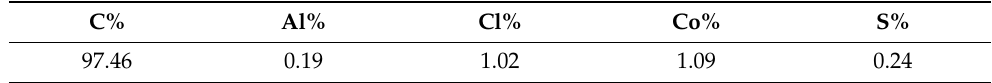
Table 1. MWCNTs’ chemical mixture.